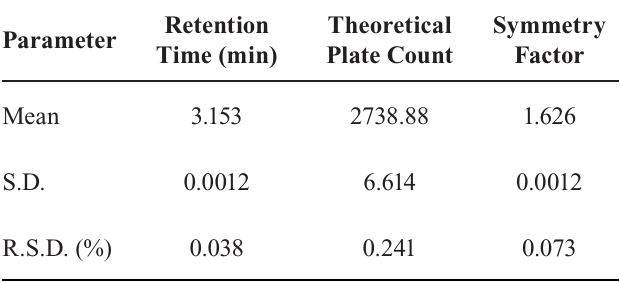
Table V - R esults of control charts obtained for CQAs Parameter